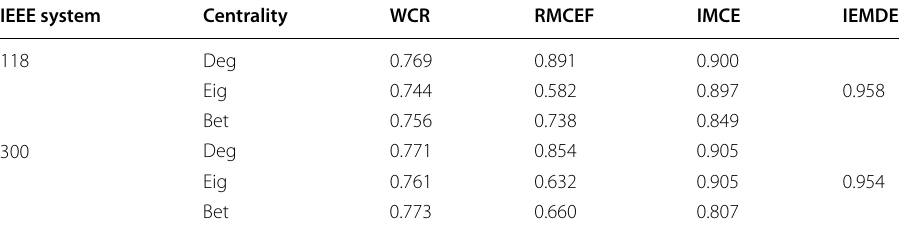
Table 6 Comparison of the VPM for the different attack profiles under consideration IEEE system